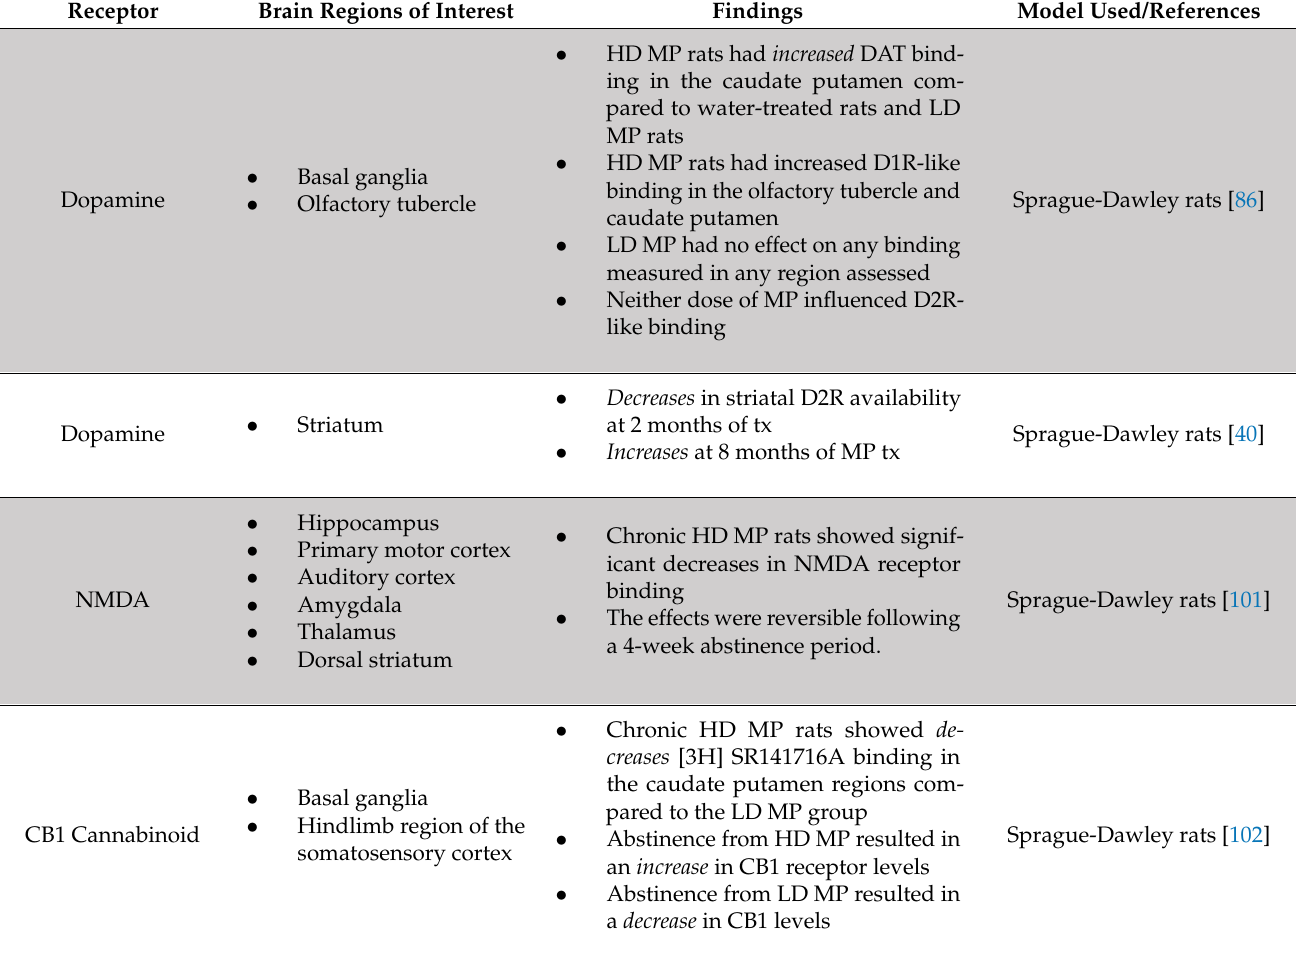
Table 5. Summary of the neurochemical effects of chronic oral